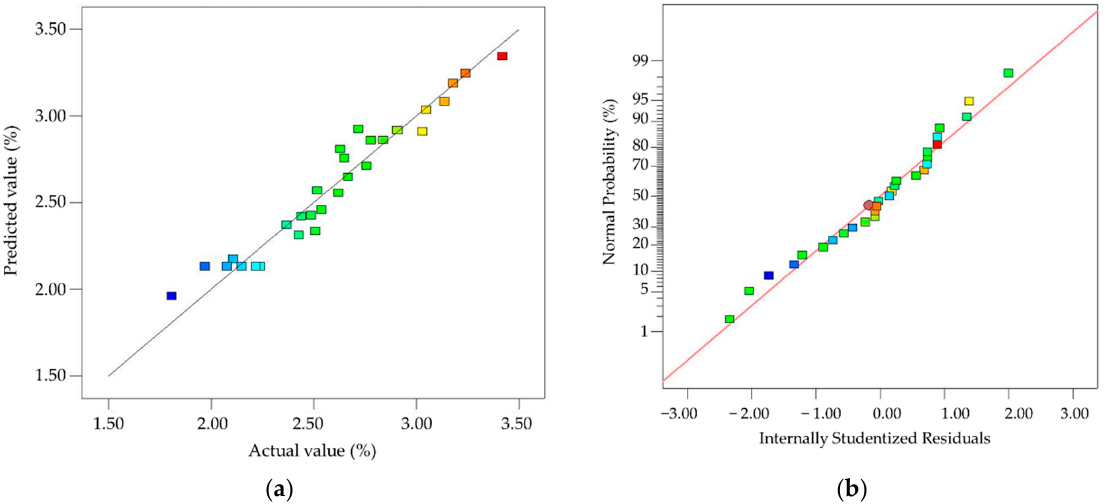
Figure 11. The detection plot of the regression model for the loss rate. ( a ) Analysis of the predicted and actual values of the loss rate. ( b ) The residual analysis of the loss rate.